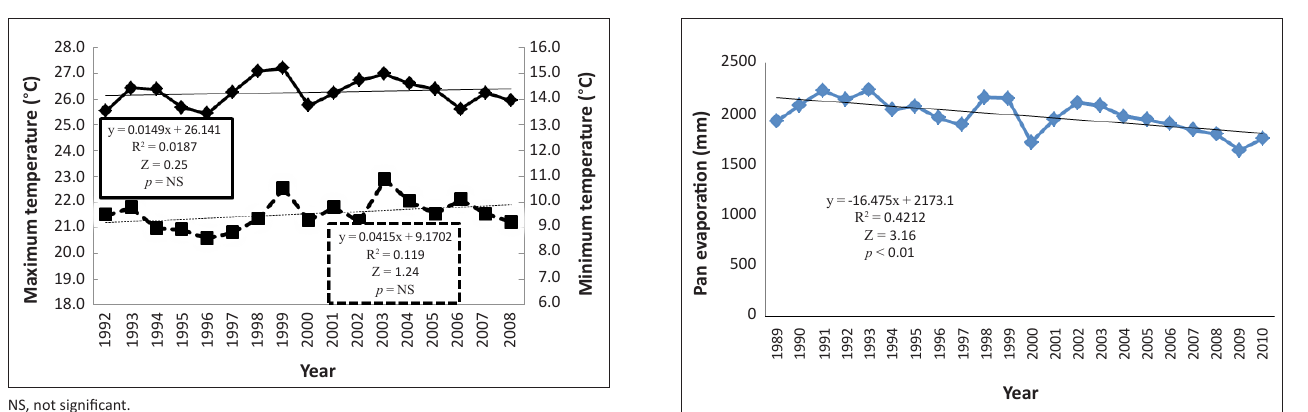
FIGURE 2: Long-term annual maximum and minimum temperature for the study area (Graaff-Reinet) from 1992–2008.